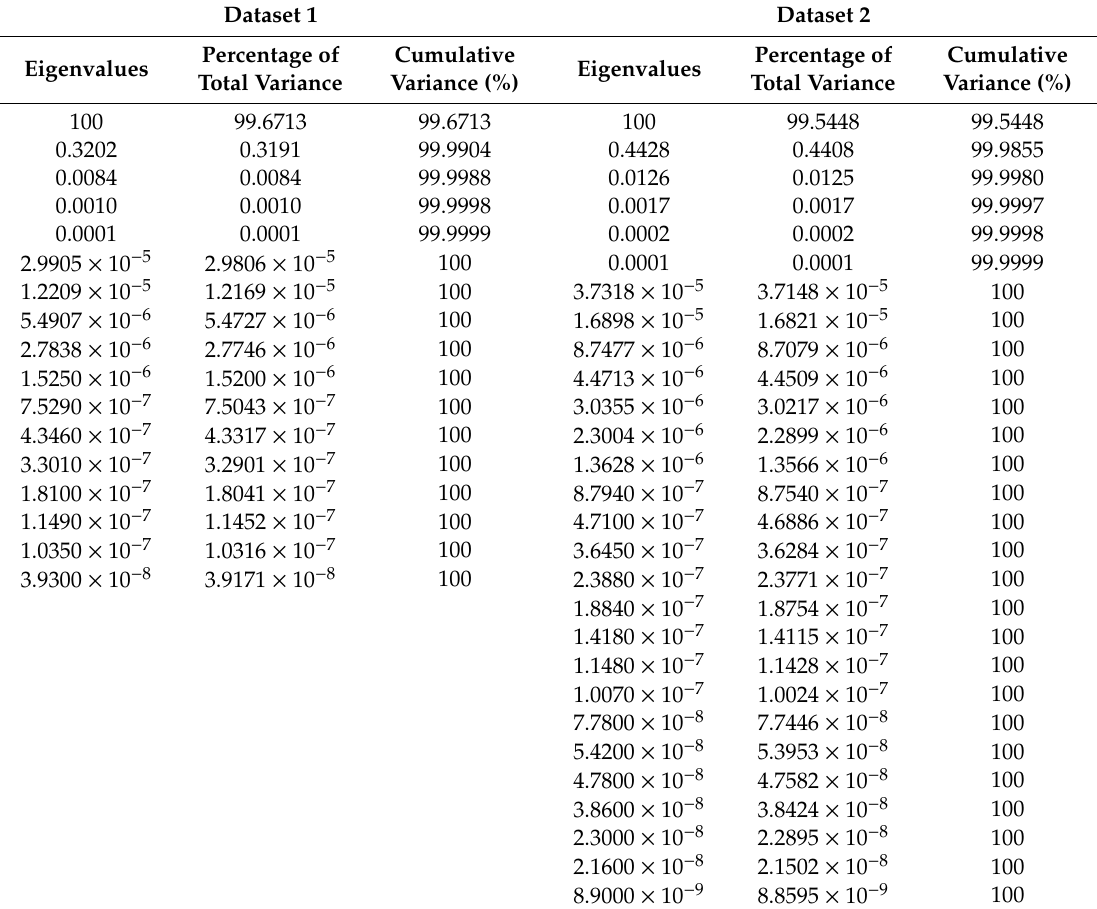
Table 2. Eigenvalues for both datasets of the WTI light sweet crude